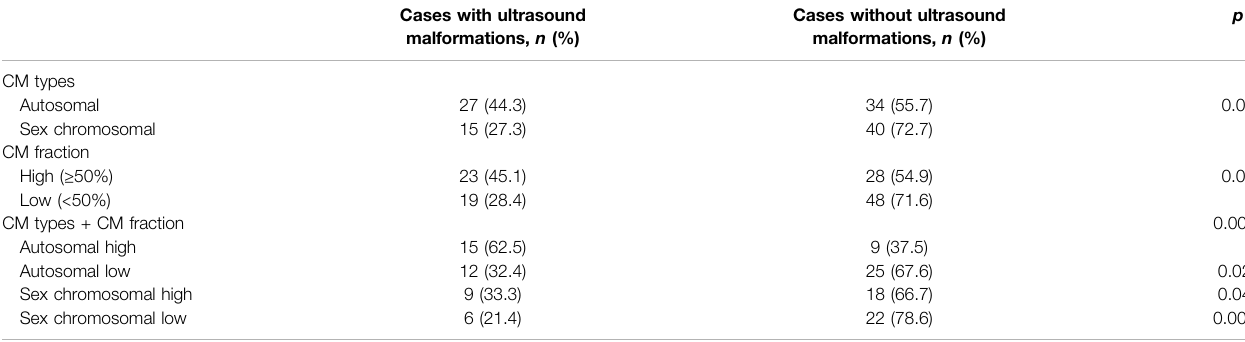
TABLE 2 | Associations of CM types and CM fractions with ultrasound malformations.